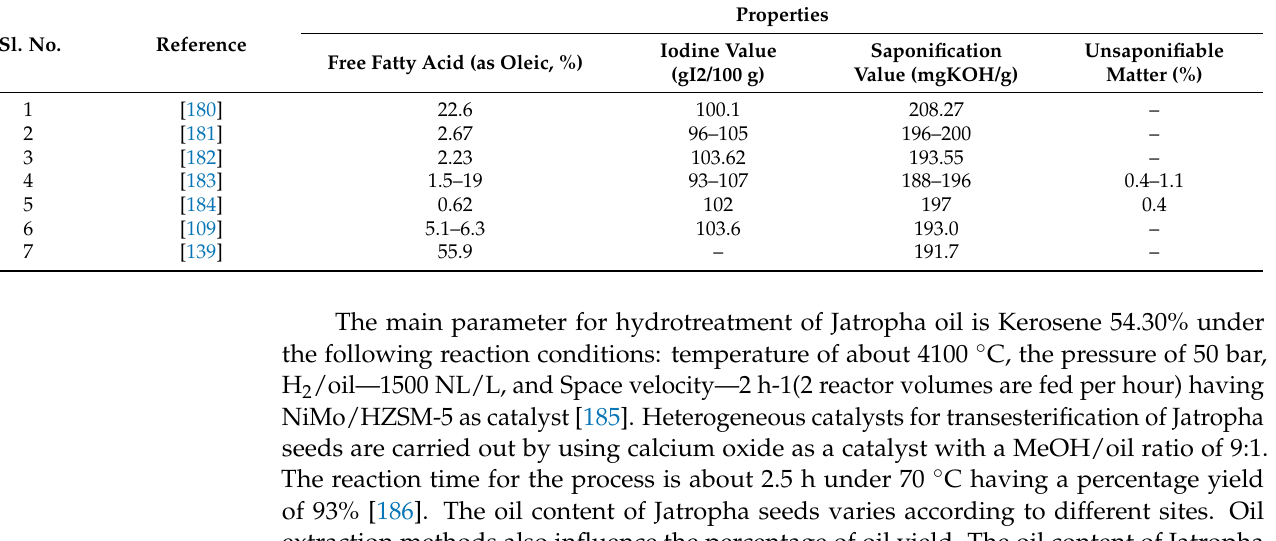
Table 6. Physio-chemical properties of Jatropha oil.